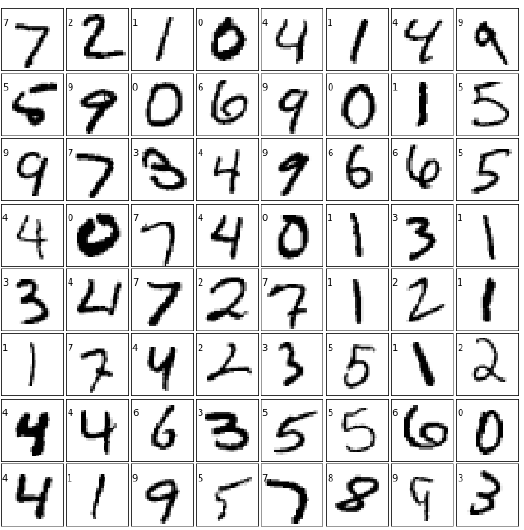
Figure 1. Random character samples from MNIST [5] dataset (28x28